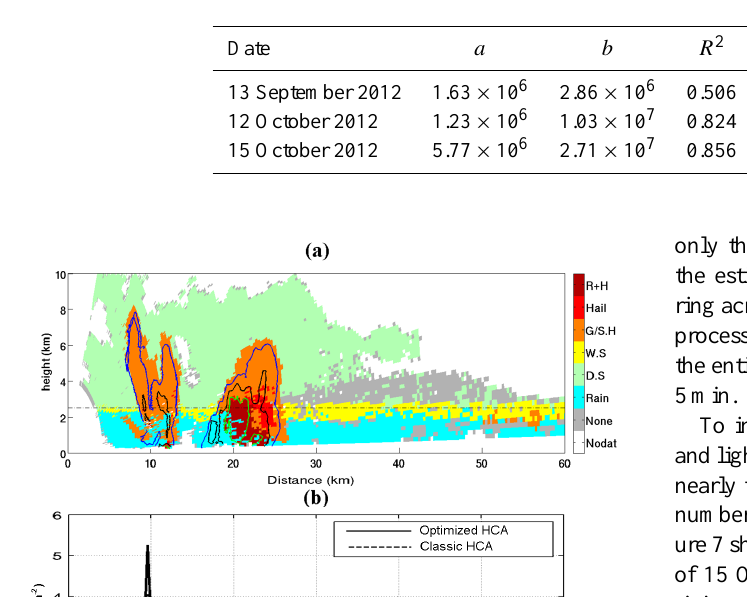
Table 4. Coefficients for the linear regression ( y = ax + b) and coefficient of determination ( R 2 ) obtained for the three case studies shown in Fig. 8. The first three parameters concern the TAG obtained from the new scheme of HCA, while the next three parameters from TAG are obtained by the former HCA.